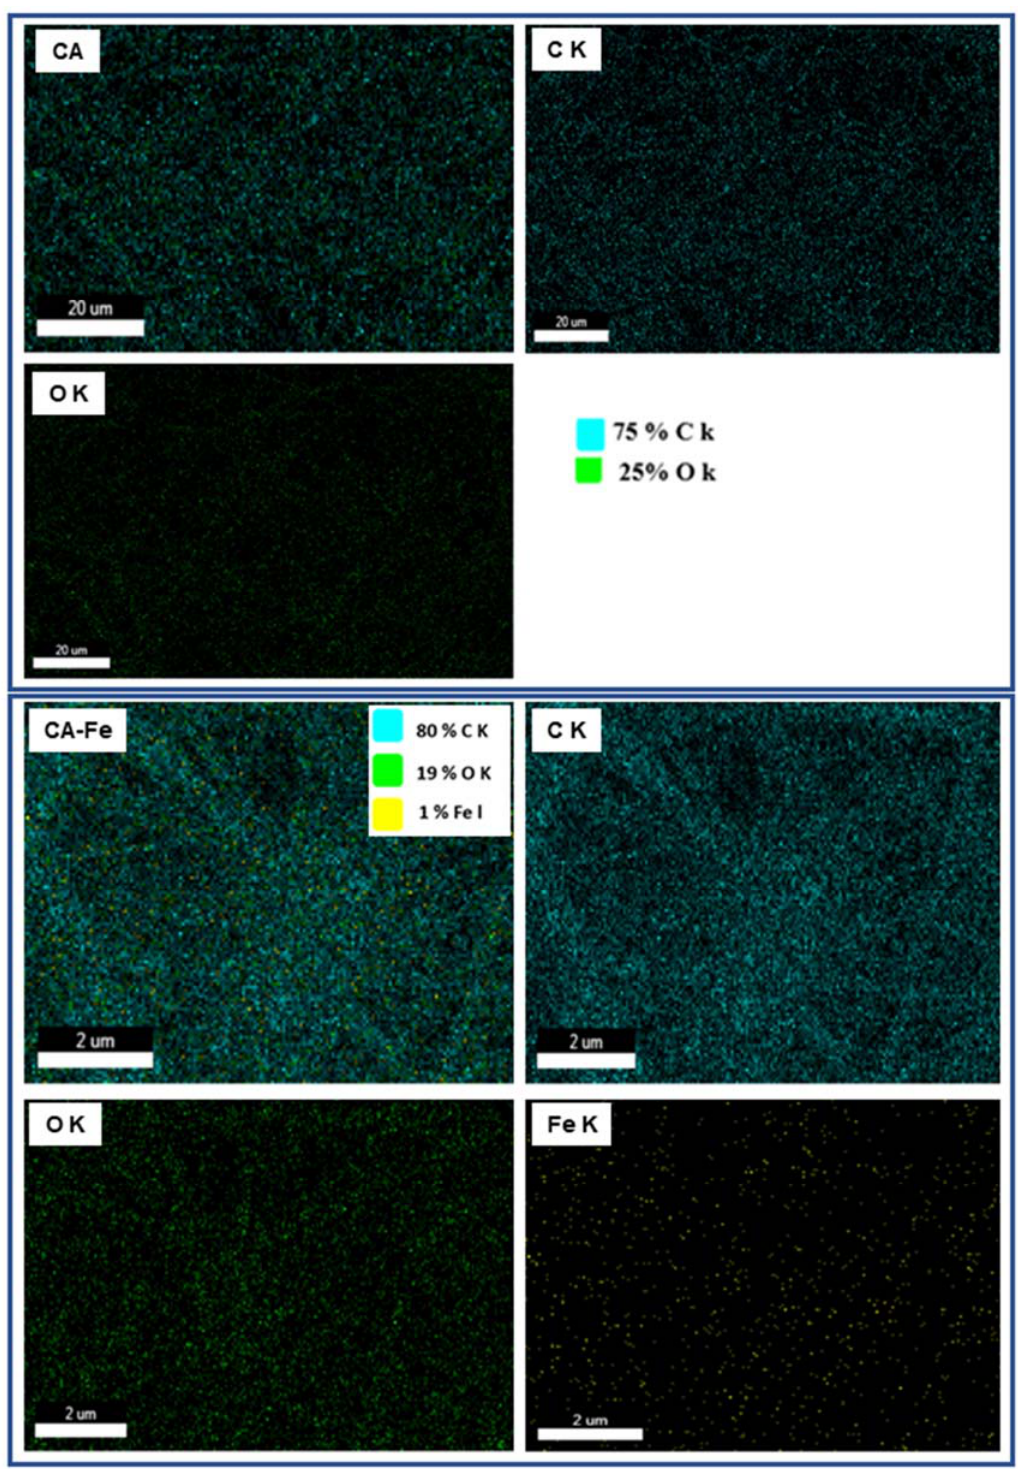
Figure 2. Figure illustrates the EDS mapping images of the two developed mats (labeled from left as CA and CA/Fe).